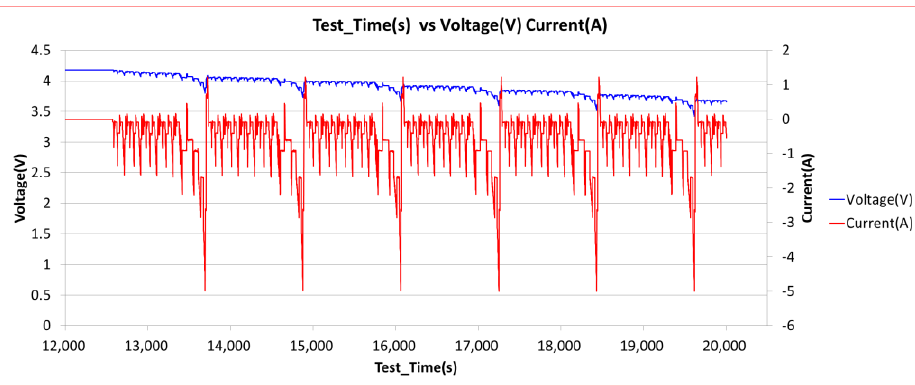
Figure 9. Local display of NEDC working conditions.